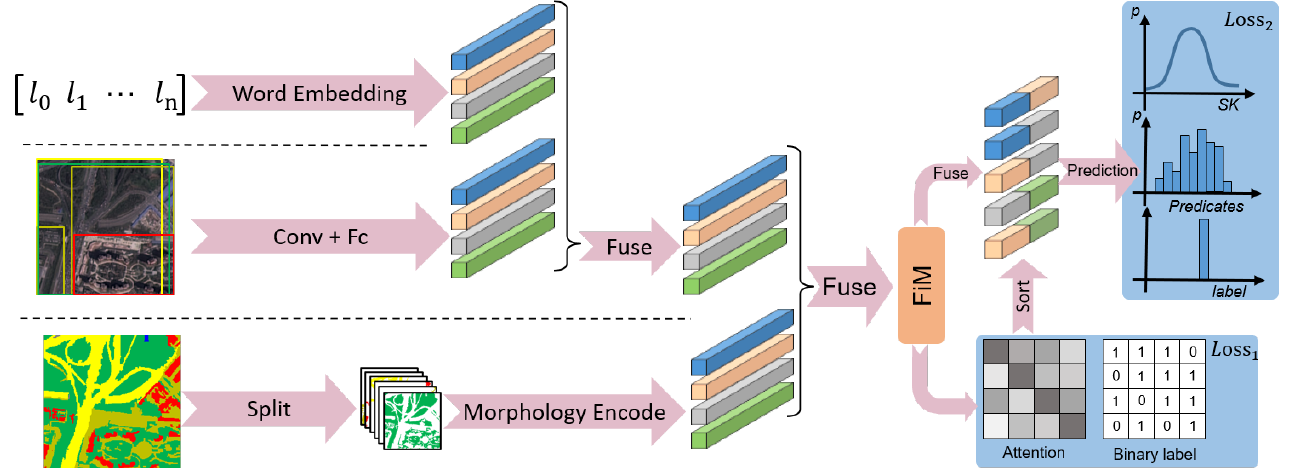
Figure 2. The framework of the RSSGG_CS model. From top to bottom, on the left side of the model are the object category semantic embeddings branch, the visual feature extraction branch, and the segmentation results morphological feature encoding branch. Then, the features of different dimensions are fed into the FiM model to calculate attention and fused to predict the relationship predicates. Attention is used to compute Loss 1 with binary labels and guide objects for combining and sorting. The Loss 2 will be calculated using predicted output and statistical knowledge as well as labels. When testing, the predicate predicted by the model represents the semantic relationship for the current object pair, so a series of triples, <subject-predicate-object>, are generated to make up the scene graphs of the input